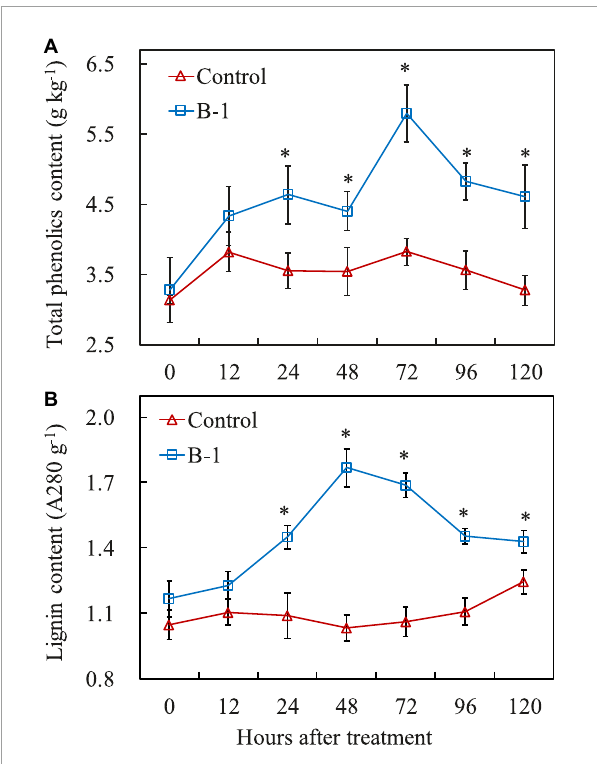
FIGURE7 The content of total phenolics (A) and lignin (B) in apple fruit treated with P. syringae B-1 at 1 × 10 8 CFU mL– 1 stored at 25 ◦ C. Each data represents the mean ± SD of three replicates. Asterisks ( ∗ ) denote a significant difference ( p < 0.05) between the strain B-1 treatment and the control apple fruit at the same time point.